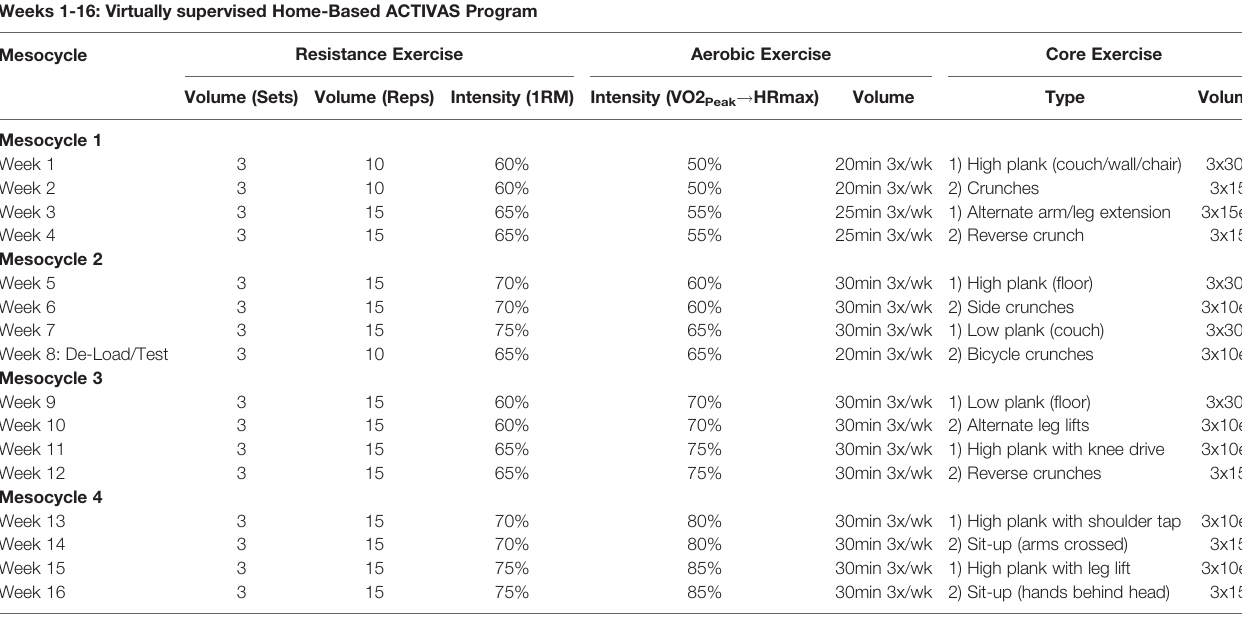
TABLE 1 | Overview of Phase 1: Virtually supervised home-based intervention (ACTIVAS program). Weeks 1-16: Virtually supervised Home-Based ACTIVAS Program Resistance Exercise Aerobic Exercise Core